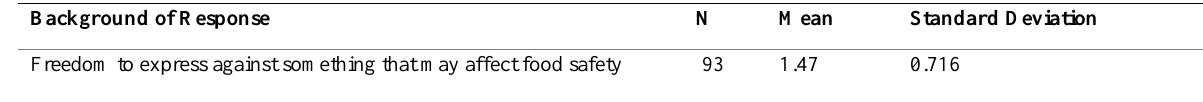
Table 1 : Freedom to Express Against Something that May Affect Food Safety